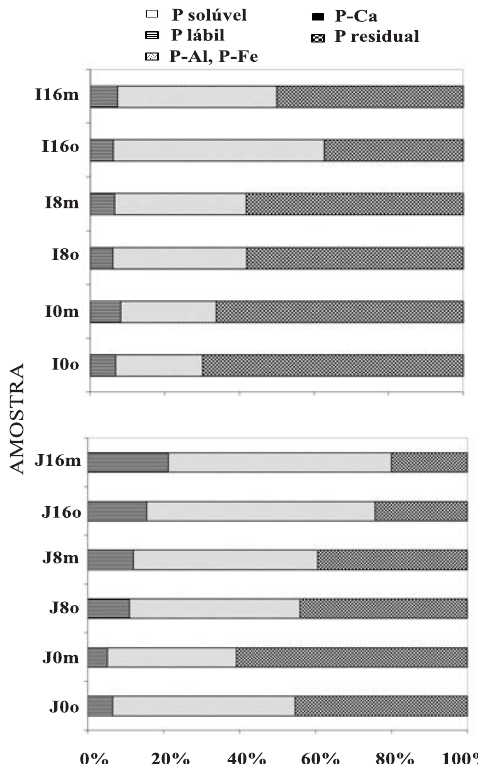
Figura 4. Distribuição de P no fracionamento das amostras de solos de Jaguariúna (J) e Itatinga (I). Ver codificação das amostras no quadro 1.